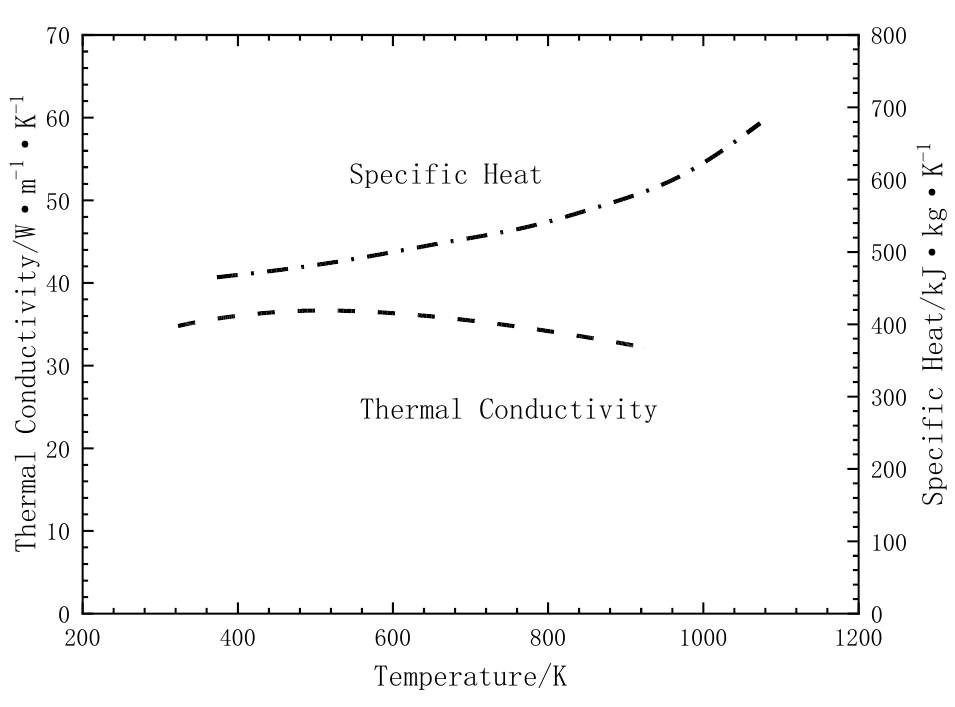
Figure 1. Cooling wall tube drawing.